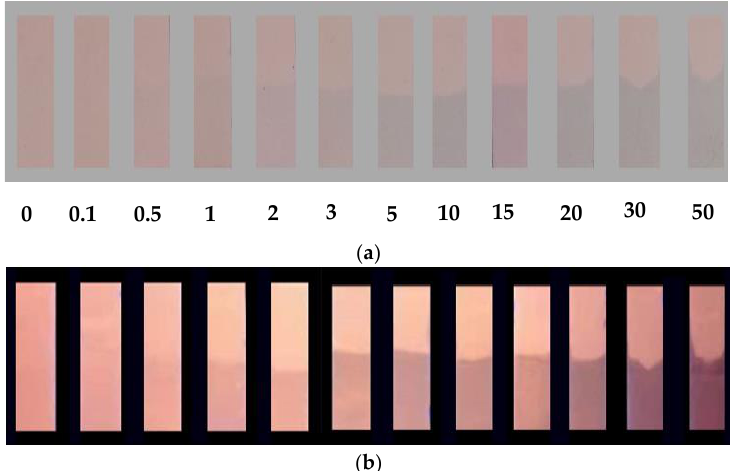
Figure 10. Photographs of the test strips under ( a ) visible light and ( b ) UV light at 365 nm after incubation in Cu 2+ ion aqueous solution (0, 0.1, 0.5, 1, 2, 3, 5, 10, 15, 20, 30 and 50 mM).